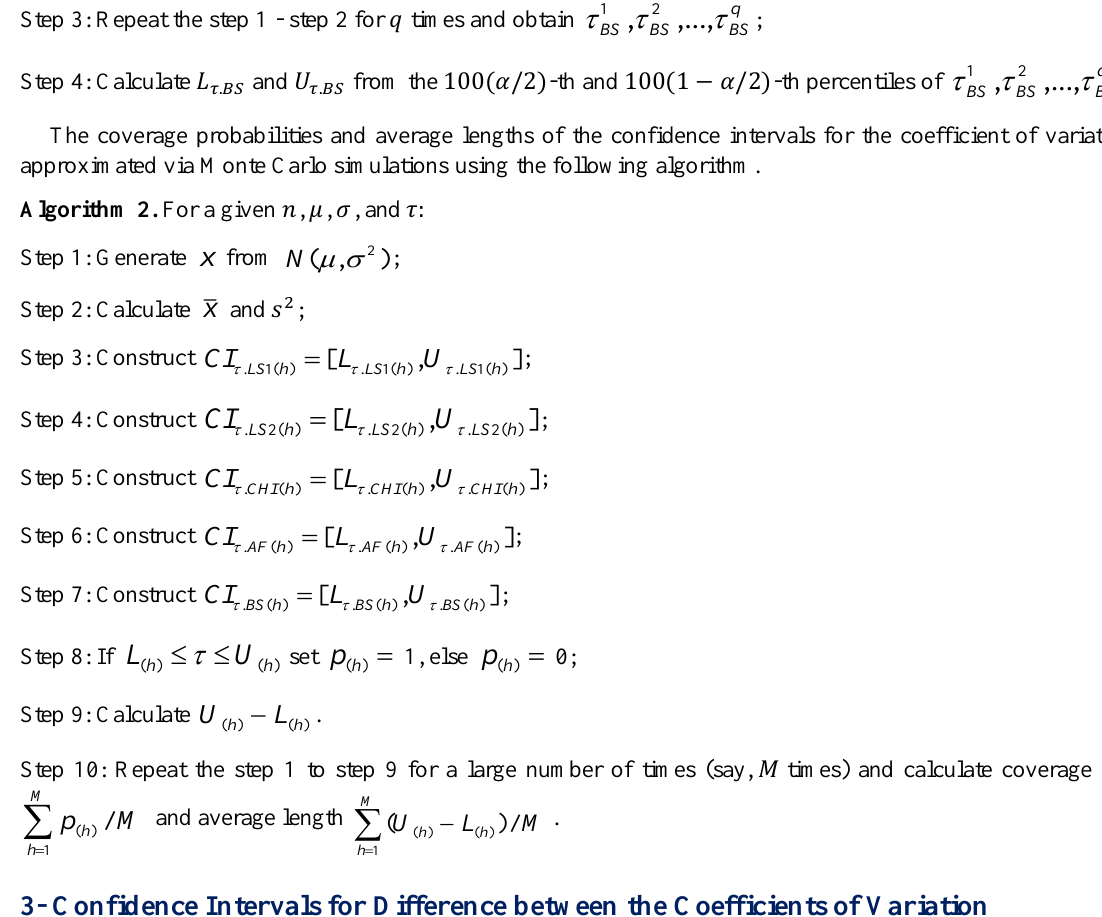
Algorithm 2. For a given 𝑛 , 𝜇 , 𝜎 , and